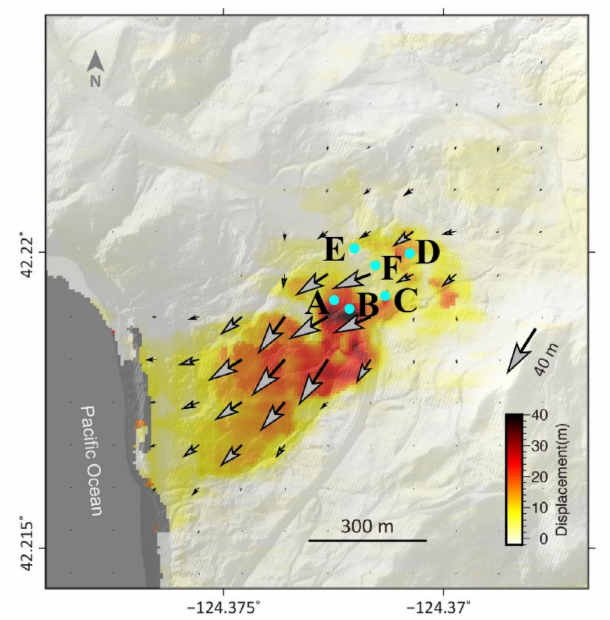
Figure 7. Three-dimensional displacement field of the February 2019 movement of the Hooskanaden landslide reconstructed from Sentinel-1/Sentinel-2 pixel offset tracking [83].